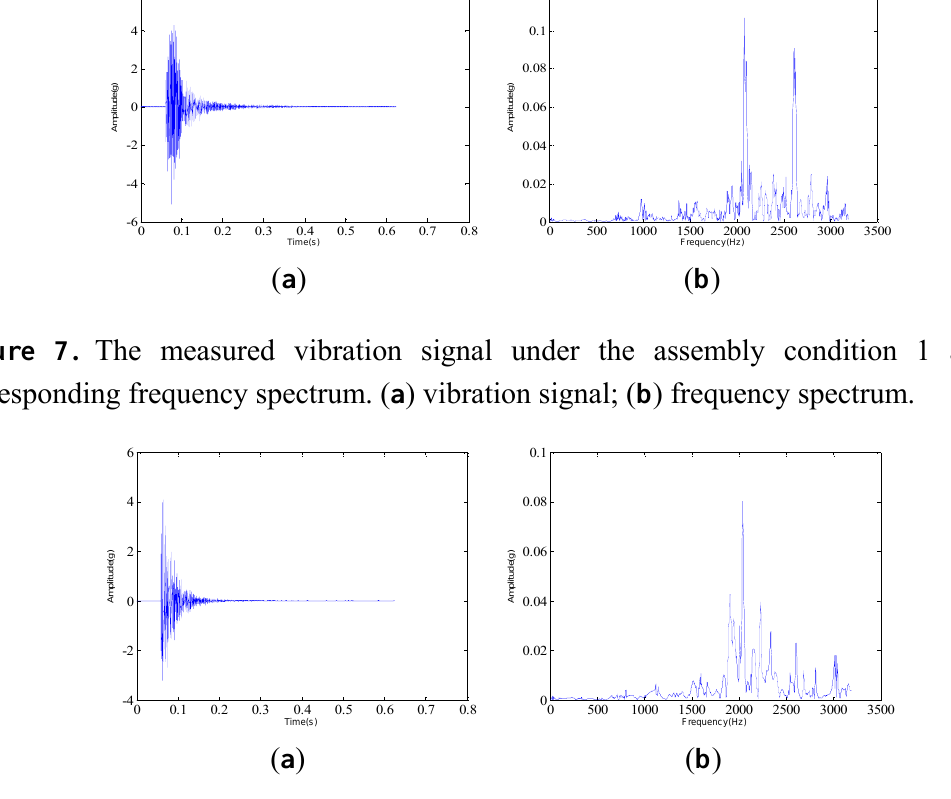
Figure 8. The measured vibration signal under the assembly condition 2 and the corresponding frequency spectrum. ( a ) vibration signal; ( b ) frequency spectrum.